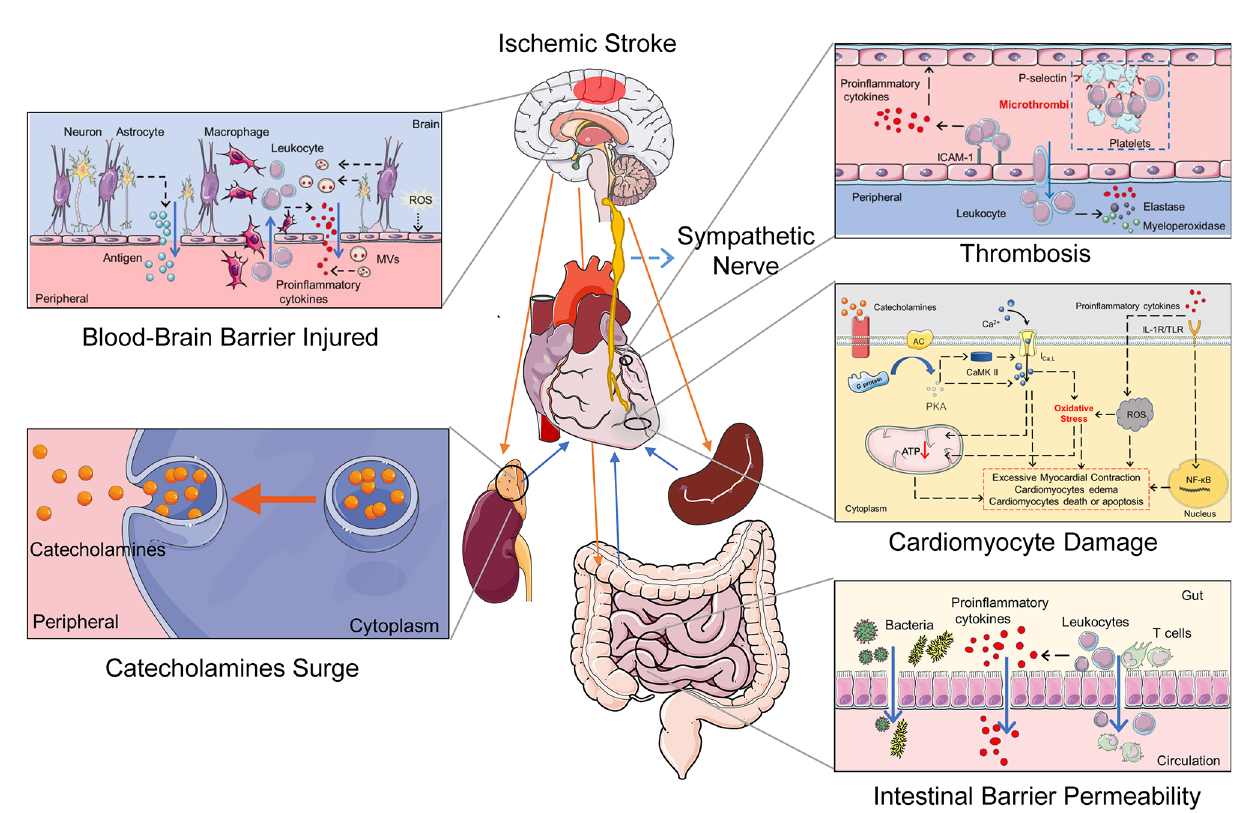
FIGURE 1 | The potential mechanisms of the cerebral-cardiac syndrome inischemic stroke. Multiple organs and systems worktogether to mediate cardiac damage after IS. The HPA axis and sympathetic nerve activationafter IS induce a catecholamine surge. Catecholamines activate the G protein – AC – cAMP – PKA cascadeand increase cytosolic Ca 2+ in the cardiomyocytes. Intracellular Ca 2+ overloadcauses cardiomyocyte damage directly. Simultaneously, sympatheticnerve activationcauses gut dysfunctionand promotes the transfer of bacteria andproin fl ammatory cytokines. Inaddition, IS damages the BBB and neurons, whichleaks the in fl ammatoryactivators to the peripheral.The spleen releases a variety of immune cellsand participates inthe activationofsystemic in fl ammationafter IS. Increased in fl ammatorycells and proin fl ammatory cytokines induce thrombosisand oxidative stress in cardiomyocytes, ultimatelyleading to cardiac damage. IL-1R, IL-1 receptor; TLR, Toll-like receptor; ROS, reactive oxygen